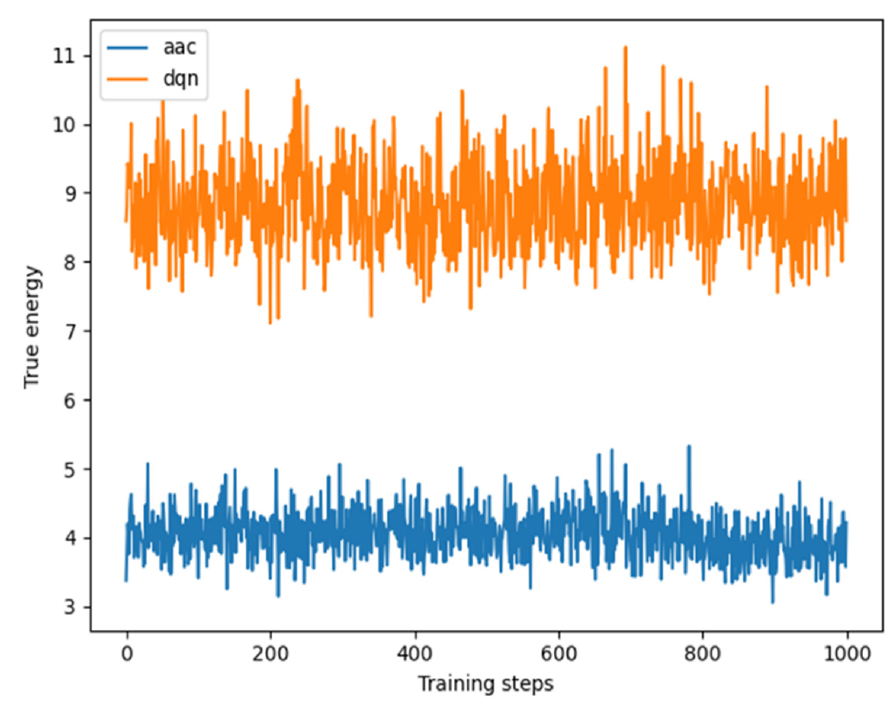
Figure 6. Total system energy consumption based on improved AAC multi-leakage real-time detec- tion algorithm and DQN algorithm.